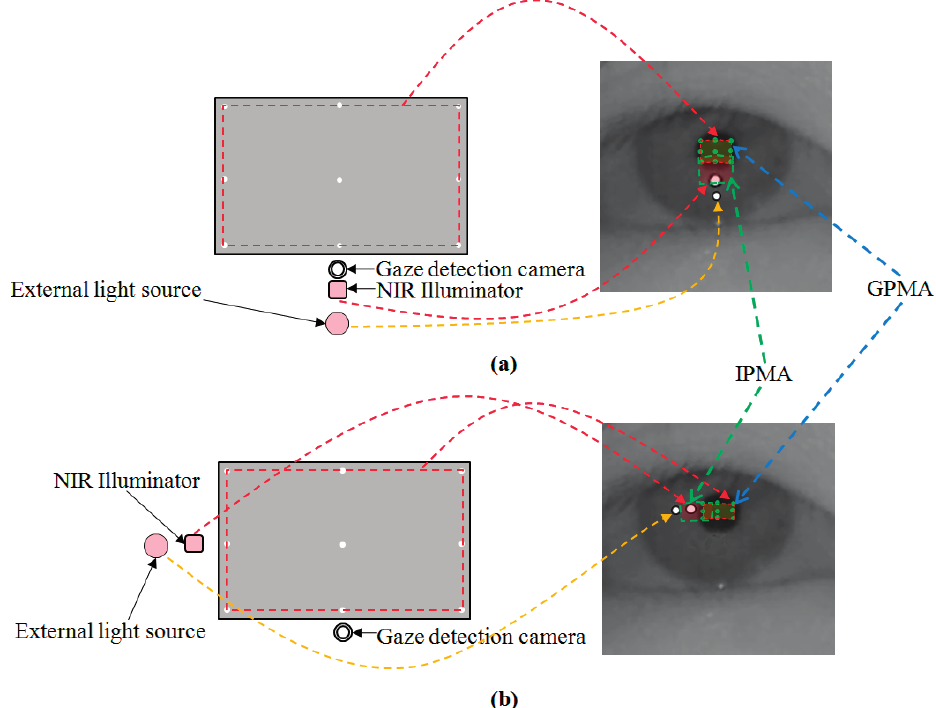
Figure 15. Second scenario (external light source exists at the same direction as the NIR illuminator based on the monitor display), and corresponding GPMA and IPMA: ( a ) External light source exists in the lower position of monitor display; ( b ) External light source exists in the left position of monitor